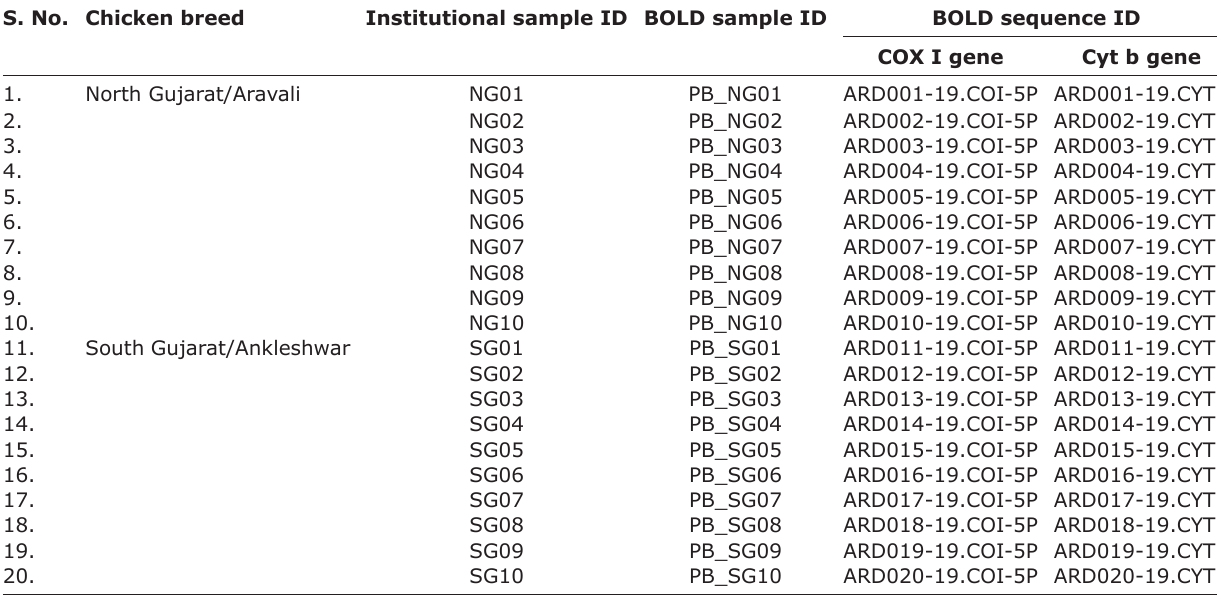
Table-5: Unique BOLD sequence IDs of submitted sequences in BOLD SYSTEMS for respective